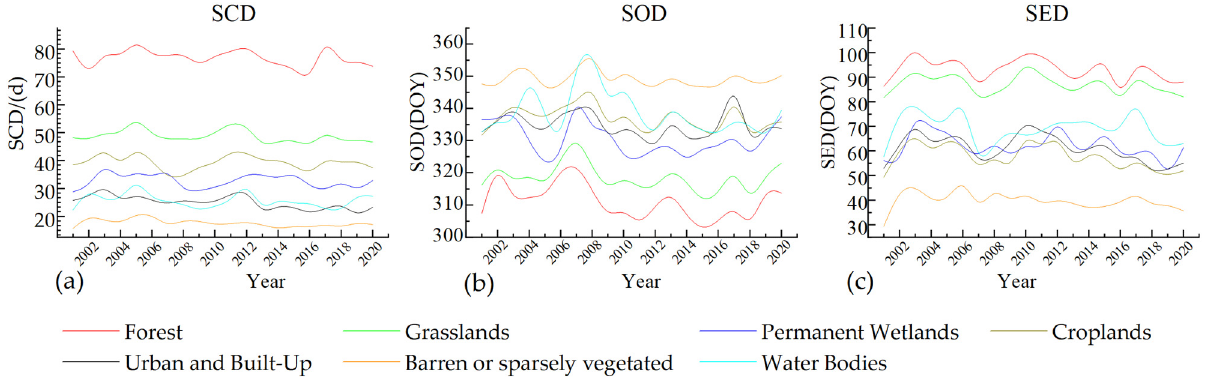
Figure 8. Variations of snow cover phenology under different land-use types: SCD ( a ); SOD ( b ); and SED ( c ).